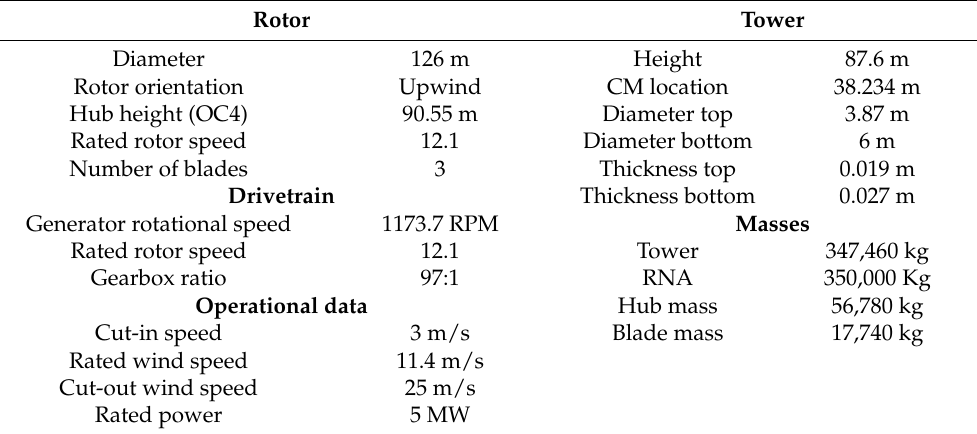
Table 2. NREL 5-MW specifications [27].